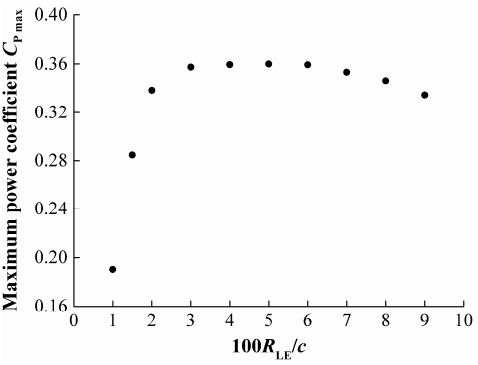
Figure 8. Variation of C P max with respect to 100 R LE / c for the rotors with different airfoil leading edge radius.